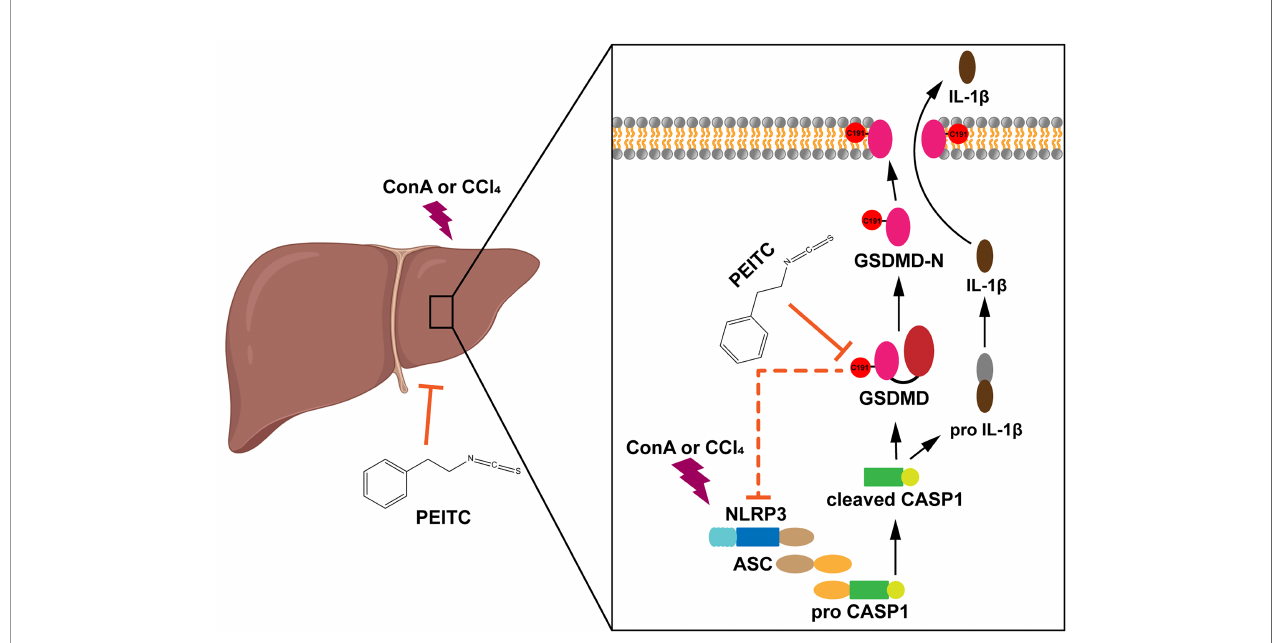
FIGURE 8 | Diagram of the effect of PEITC in inhibiting hepatocyte